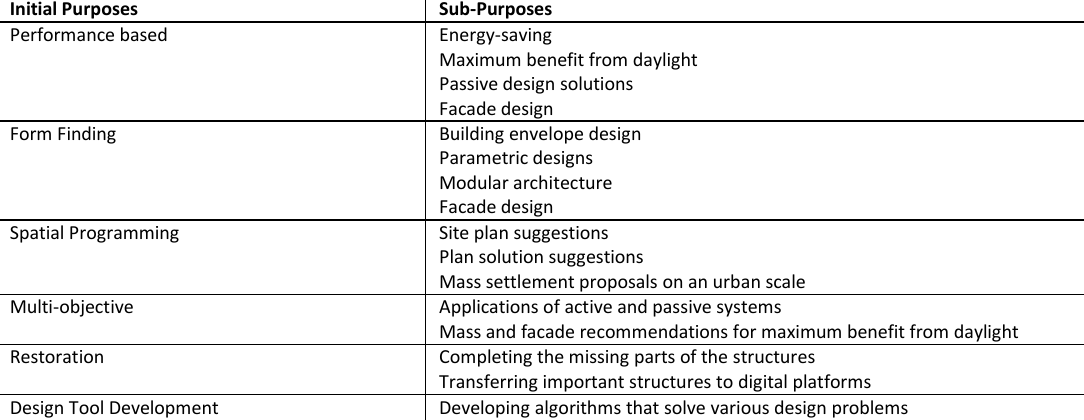
Table 1 The initial and sub-purposes of architecture's usage of artificial